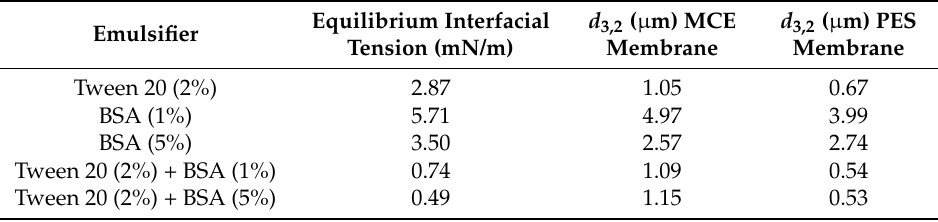
Table 2. Interfacial tension between sunflower oil and water at room temperature for different emulsifier systems used for premix membrane emulsification with nitrocellulose mixed ester (MCE) and PES membranes and final droplet size after five emulsification cycles. Emulsification with